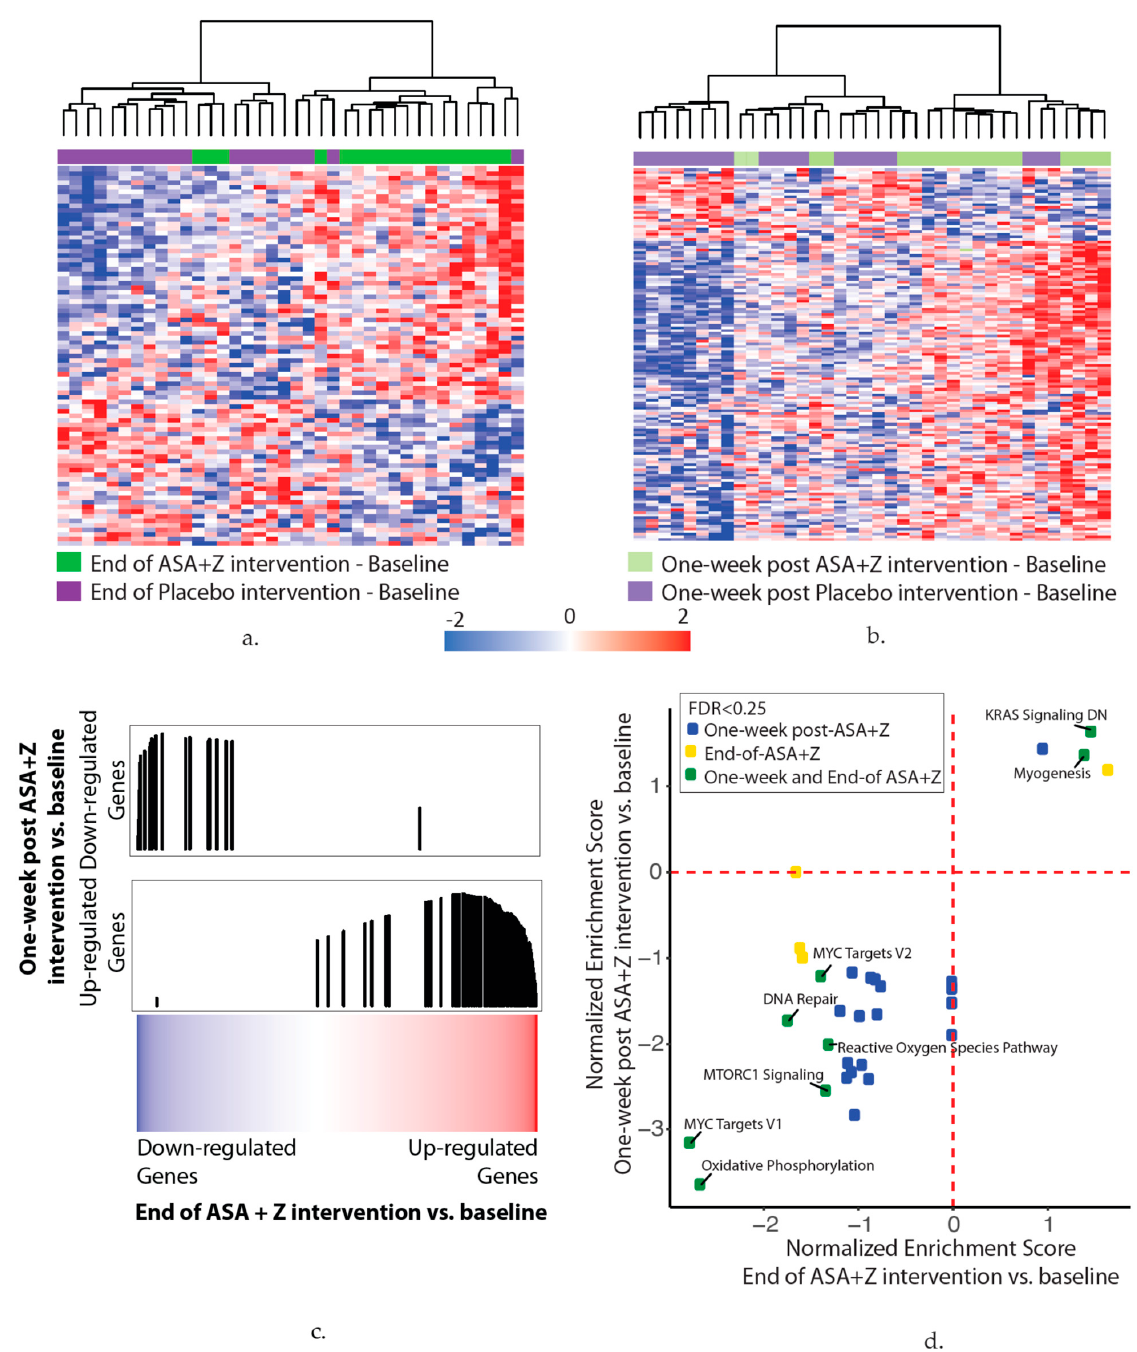
Figure 4. ( a – d ) Aspirin and zileuton treatment alter nasal gene